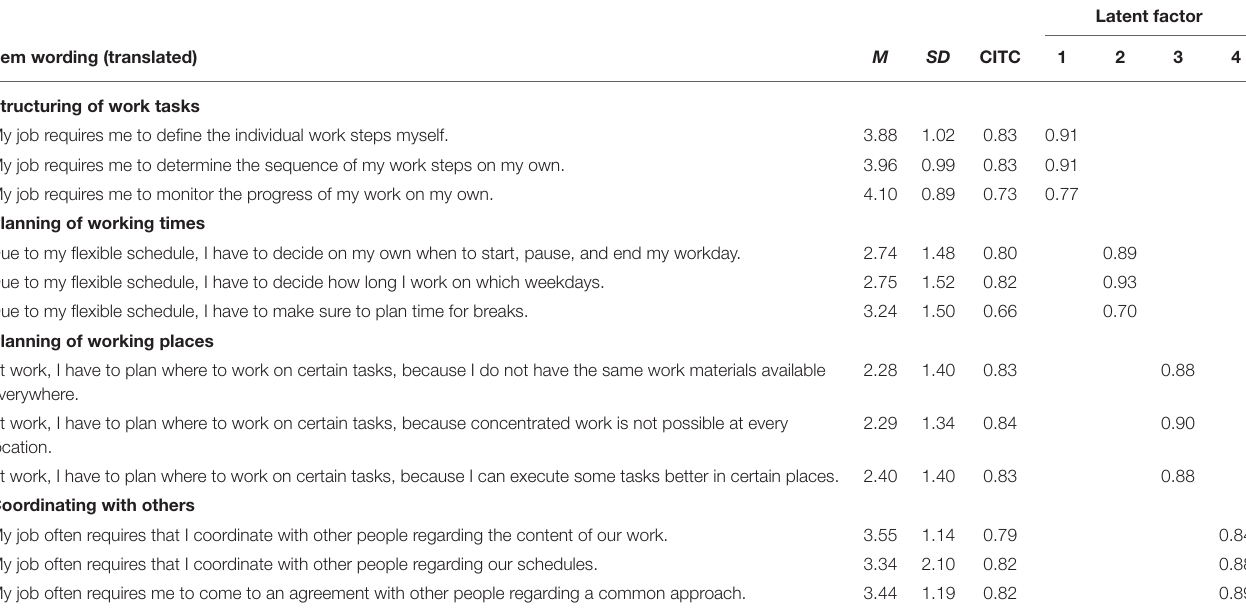
TABLE 2 | Item wording, means and standard deviations, corrected item-total correlations, and standardized factor loadings from confirmatory factor analysis.